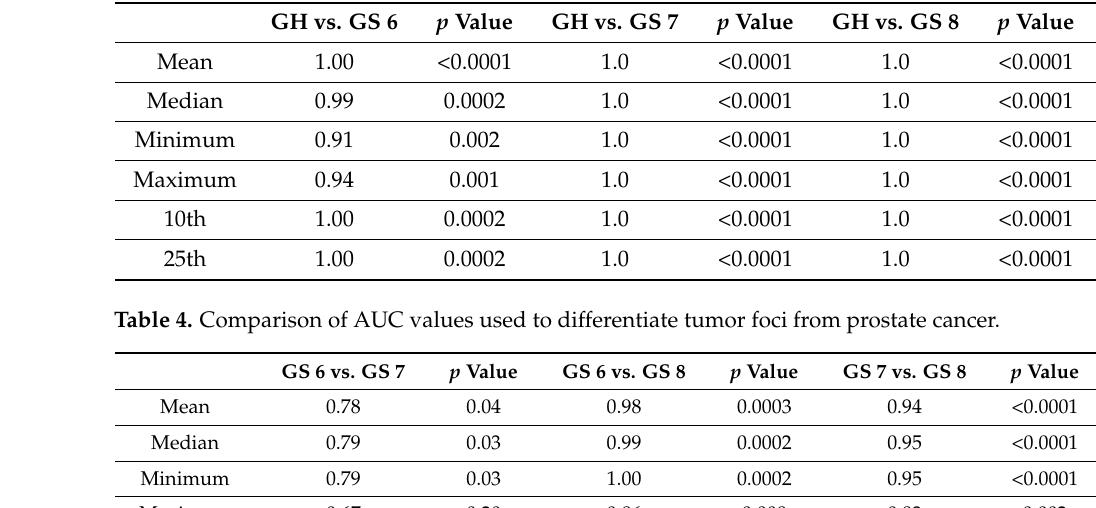
Table 3. Comparison of AUC values used to differentiating tumor foci from glandular hyperplasia.